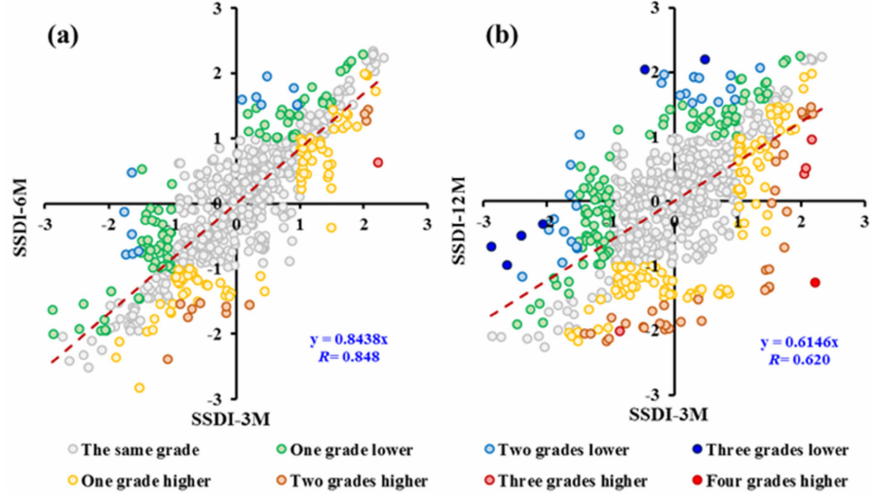
Figure 9. Scatter plot between ( a ) SSDI-3M and SSDI-6M; ( b ) SSDI-3M and